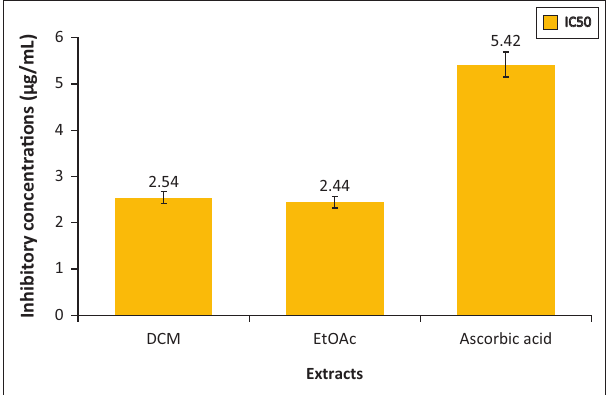
The two active extracts (DCM and EtOAc) were further subjected to DPPH and TPCs to determine their free radical scavenging activities. The violet colour of DPPH free radical changed to yellow on the addition of these two extracts, which indicated the conversion of DPPH free radicals to DPPH antioxidant compounds. The IC values of the extracts 50 are presented in Figure 2. The IC of the DCM extract was 50 2.54, while the value of EtOAc extract was 2.44 and that of ascorbic acid was 5.42. The indication is that the lower the IC the higher the activity. 50,